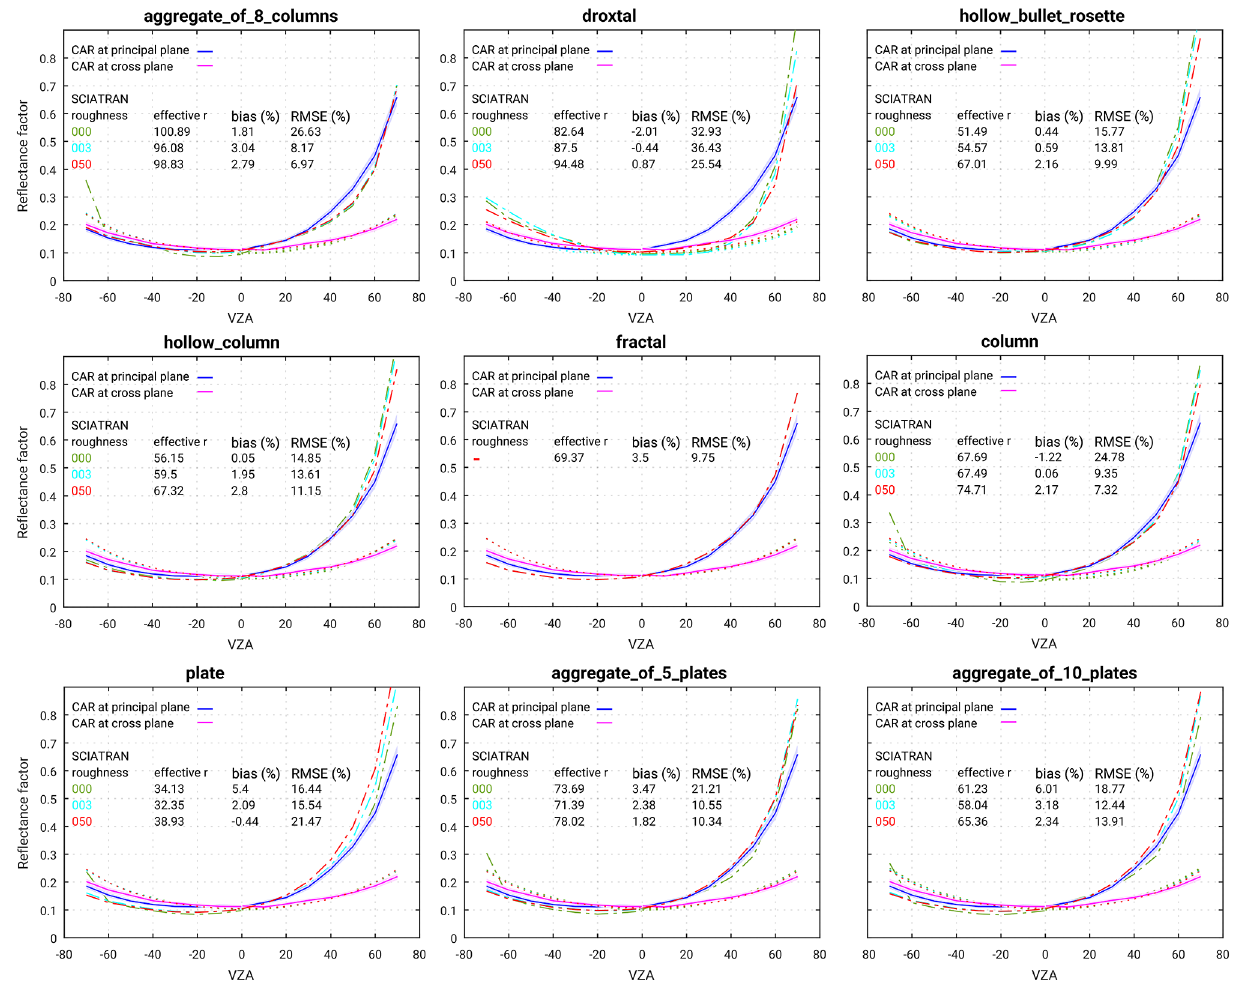
Figure 6. Comparison of measured and simulated reflectance factors. Measurements were performed by the CAR instrument over old snow at 647m flight altitude on 7 April 2008 at 1.649µm. The uncertainty in CAR measurements is indicated by the envelope (shading). SCIATRAN simulations in the principal and cross plane given by the dashed–dotted and dotted lines, respectively, and by different colors (green, blue, and red) present smooth, moderately roughened, and severely roughened crystal surfaces. Positive and negative VZAs correspond to azimuthal angles ϕ = 0 and 180 ◦ for the principal plane and ϕ = 90 and 270 ◦ for the perpendicular plane,